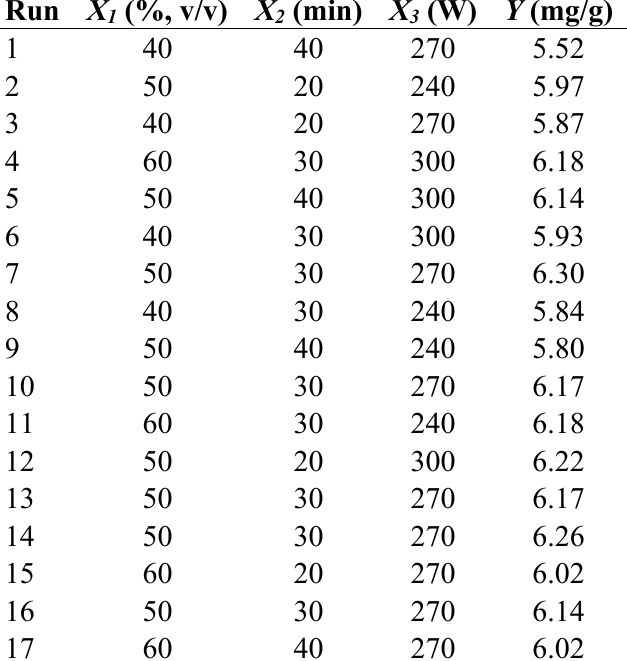
Table 1. Response surface Box-Behnken design (uncoded) and results for extraction yields of